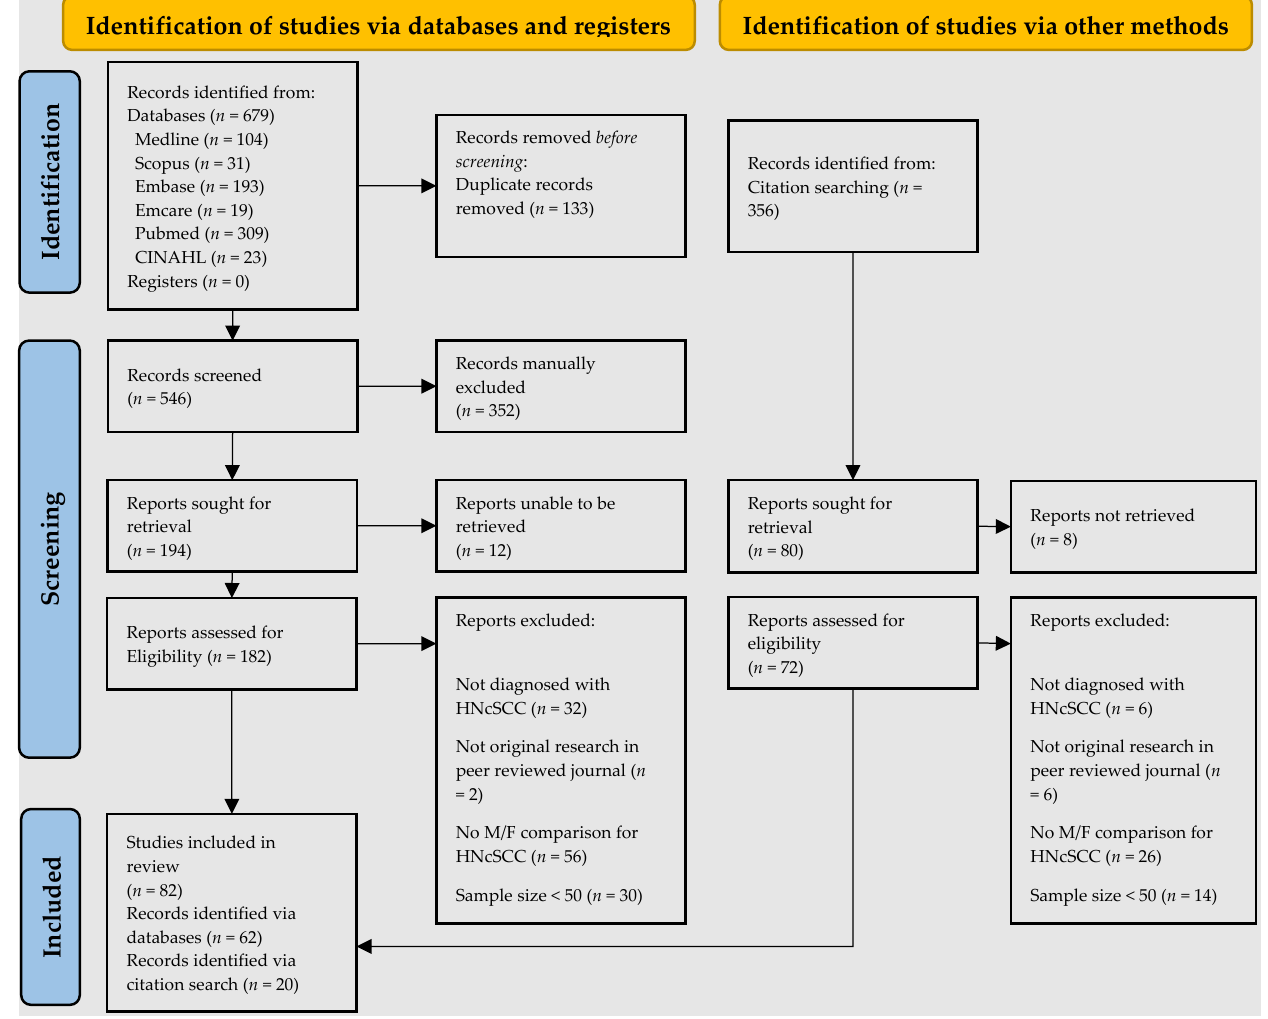
Figure 1. PRISMA flow diagram of the literature search.